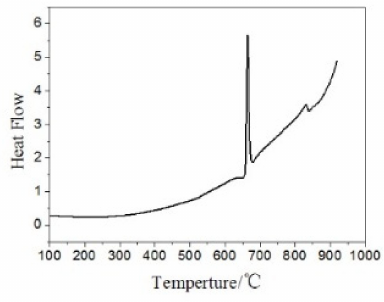
Figure 2. The differential scanning calorimetry (DSC) of Al-based alloy